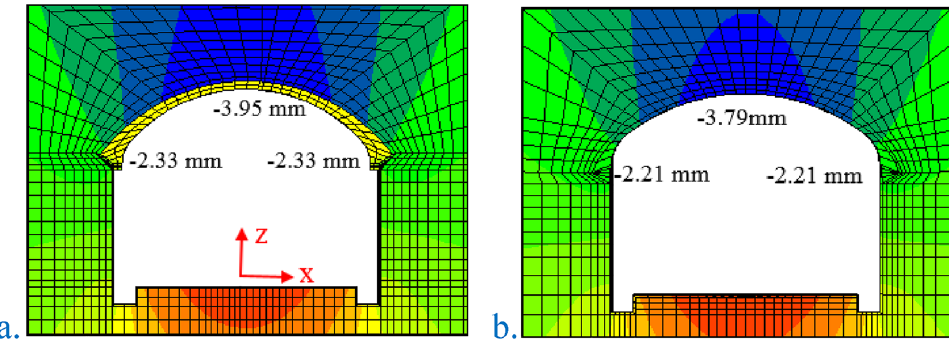
Figure 9. Vertical displacement cloud diagram of the two construction methods. ( a ) The original scheme of the SCM (IV1); ( b ) the optimized scheme of the PCM (IV1).